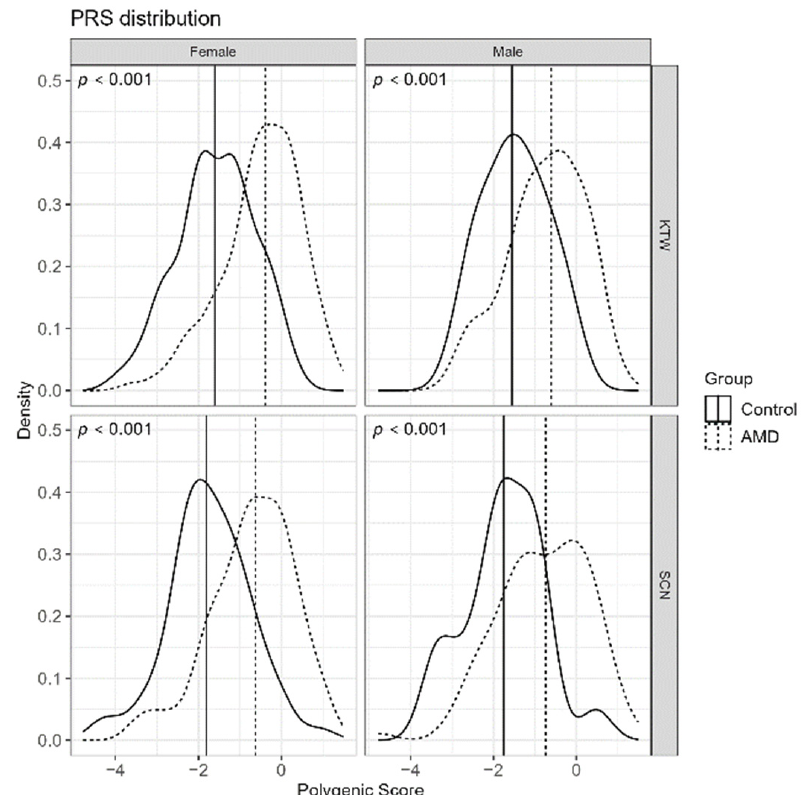
Figure 2. Distribution of PRS values per individual as density plot with median values for case/control groups marked as a vertical line in subsets when sex and the patient recruitment region (Katowice, KTW or Szczecin, SCN) were concerned.